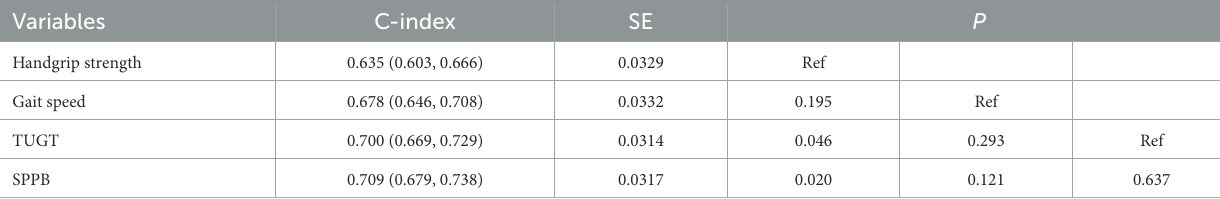
TABLE 3 Predictive values of muscle strength and physical performance measurements for mortality according to the